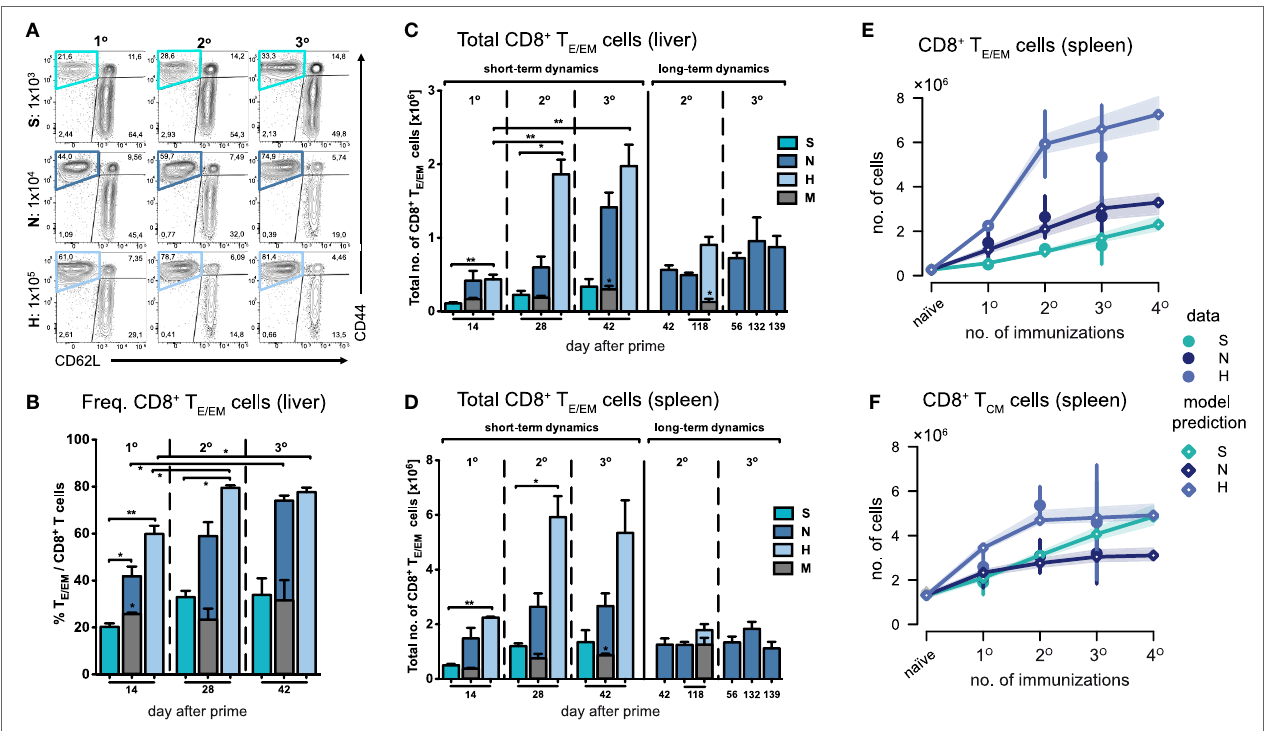
FigUre 2 | Dynamics of CD8 + T E/EM cells after varying Plasmodium berghei RAS vaccination protocols. (a) Representative FACS-plots of CD8 + T cell responses gated for CD62L and CD44 measured in the liver of mice receiving prime (1°), prime-boost (2°), or prime-boost-boost (3°) immunizations with S-, N-, or H-dose. (B) Increasing percentage of T E/EM cells among CD8 + T cells in the liver with subsequent booster injections dependent on the vaccination dose. Corresponding total number of T E/EM cells in the liver (c) and spleen (D) looking at short-term (measurements taken 14 days after last injection) and long-term dynamics ( > 14 days after last injection). Numbers below the plots indicate time of measurement in days post prime. Numbers of animals per group are specified within Table S1 in Supplementary Material. Graph bars depict means with SEM; * p < 0.05; ** p < 0.01; *** p < 0.001; multiple nonparametric rank-based relative comparison. (e,F) Measured and predicted levels of T E/EM (e) and T CM cells (F) in the spleen using a mathematical model that assumes splenic reactivation to depend on the level of hepatic T E/EM cells prior to immunization. Shaded areas indicate the 95%-confidence intervals of model